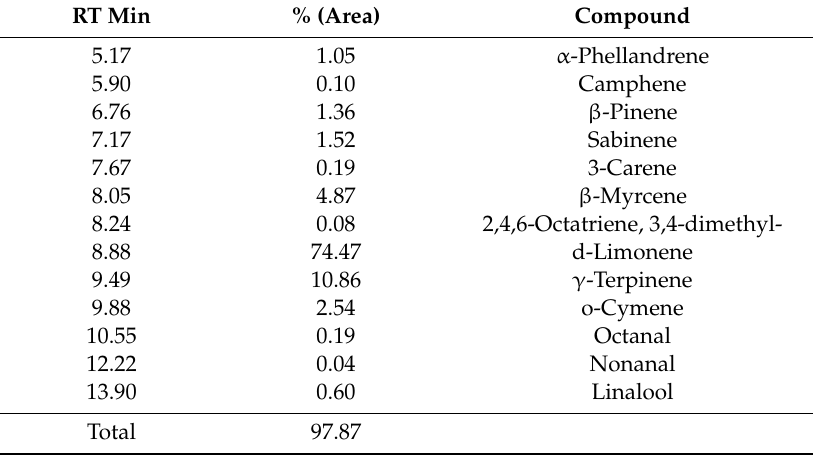
Table 1. Chemical compositions of tangerine oil.